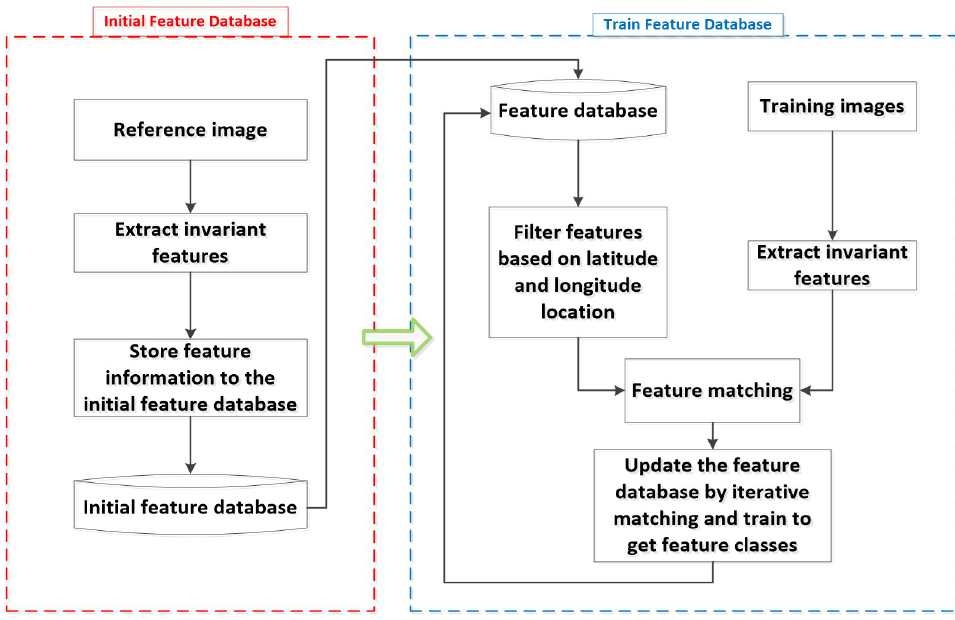
Figure 1. Main flow of the construction of the feature